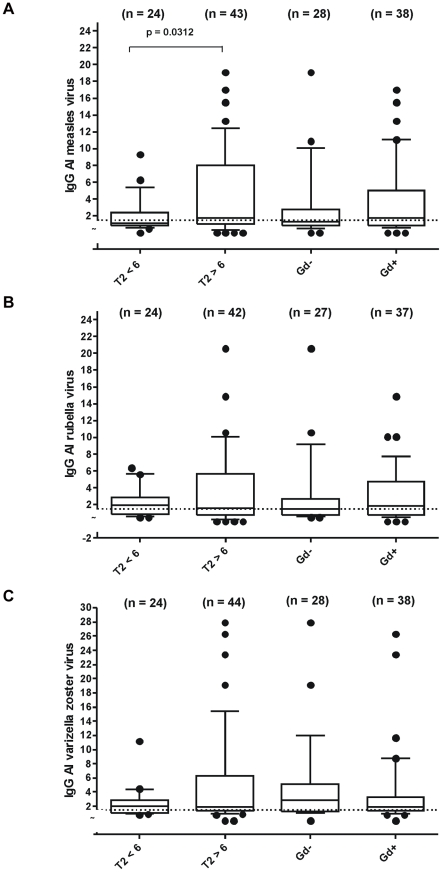
IgG antibody index of MRZR and MRI activity.IgG antibody index (AI) results for measles virus (A), rubella virus (B) and varicella zoster virus (C) for patients with <6 lesions, ≥6 lesions, no Gd-enhancing lesions and Gd-enhancing lesions on cMRI are shown as box plot graphs. The boxes include values between the 25th and 75th percentile of the distribution, while the line within the box represents the median value. The whiskers above and below the box indicate the 90th and 10th percentile, respectively, and the black dots indicate the outliers, while the dotted line at AI 1.5 indicates the upper limit of the reference range. The number of patients in each group is shown in brackets above boxes.